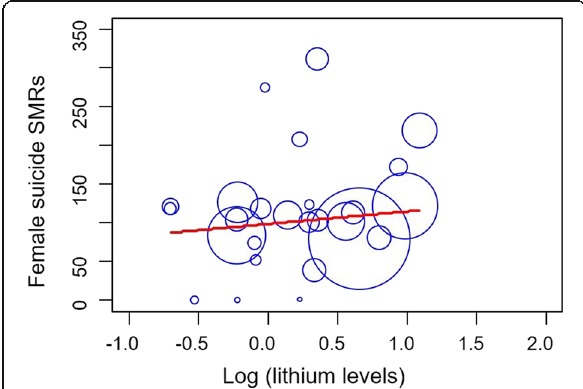
Fig. 2 Lithium levels in drinking water and female suicide SMRs. The lithium levels are log-transformed, and the size of the dot represents